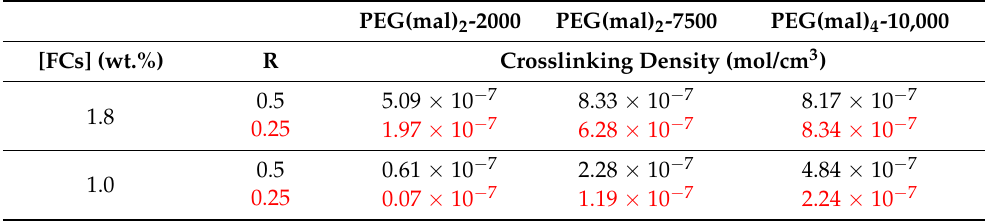
Table 4. Values of crosslinking density, ρ x , calculated from Equation (6) for hydrogels based on the Diels–Alder click reaction at different degrees of polymerization and functionalities of the PEG- maleimide compound. To keep the visual association with the curves in Figure 5, the black and red colors are